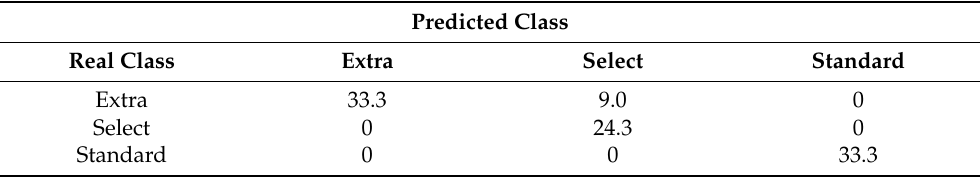
Table 4. Confusion matrix obtained through PLS-DA for Californian-style black olives stuffed with